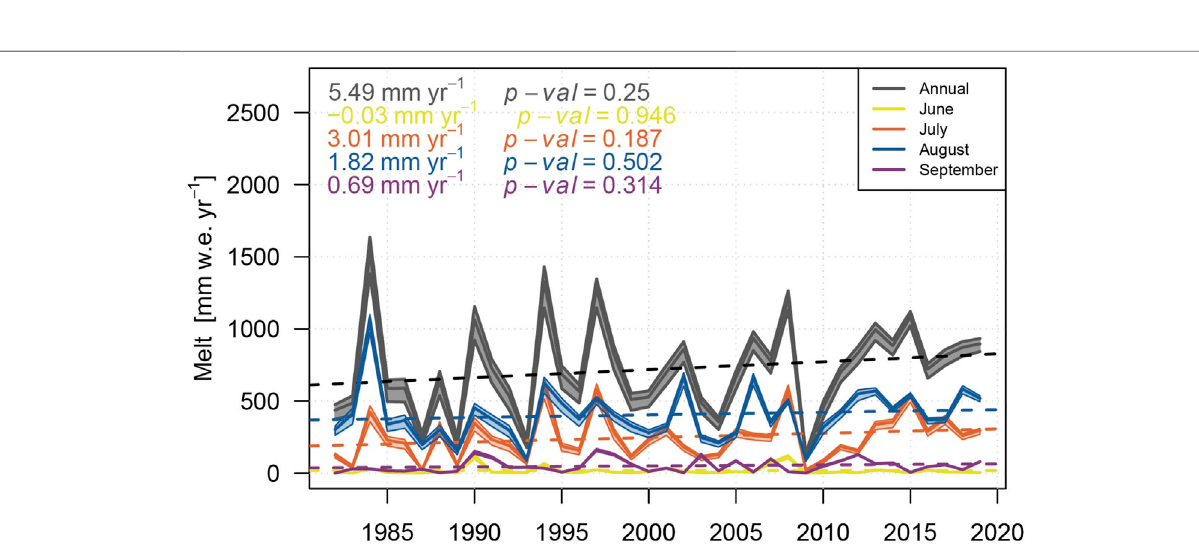
Frontiers in Environmental Science |